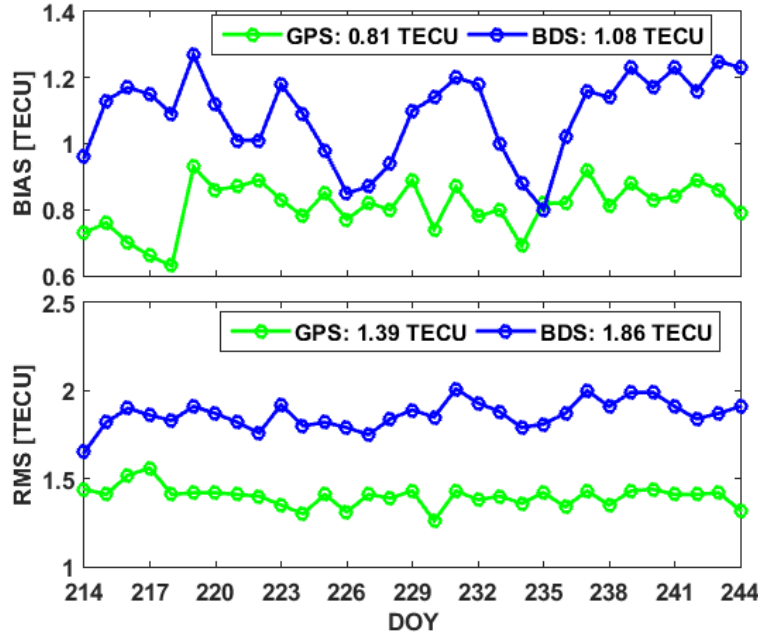
Figure 18. Time series of the mean and RMSs of the differences between the estimates and the IGS-based GIMs during the period from DOY 214 to 244 in 2020.